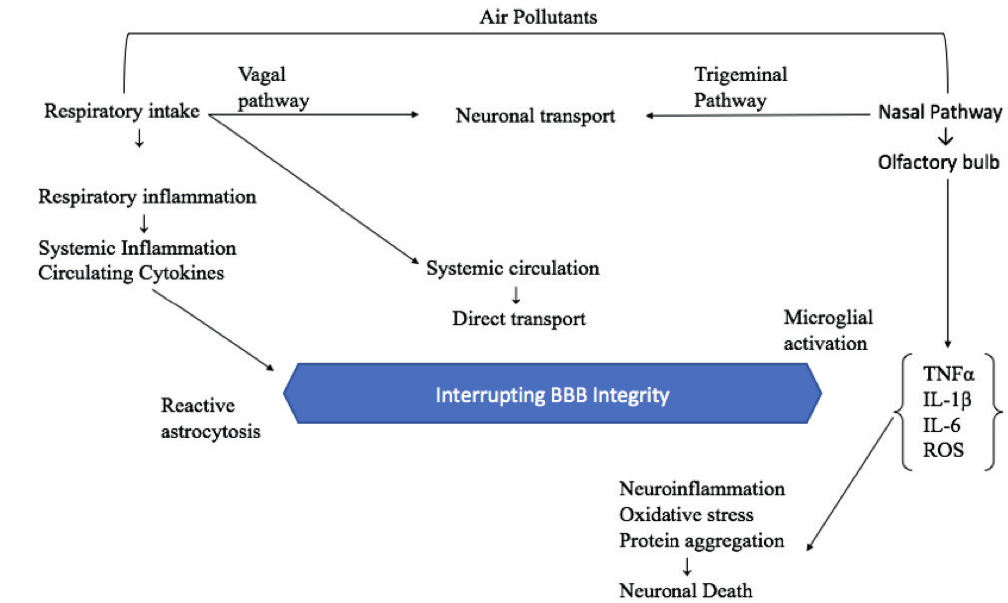
Figure 3. The impact of air pollution on the brain via multiple mechanisms. (Source: Genc et al. modified